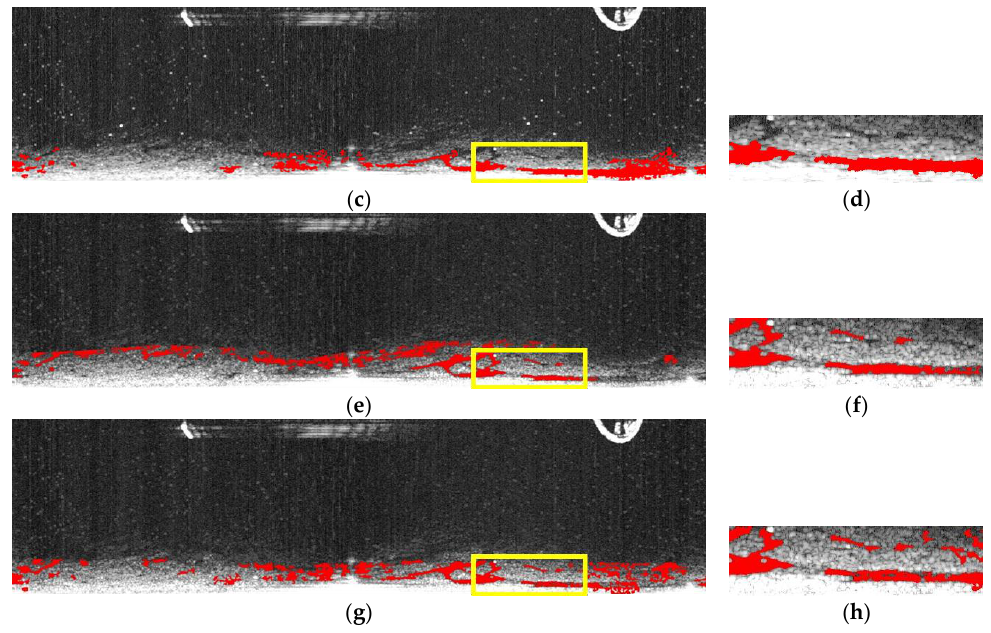
Figure 16. Comparing oil spill detection by three methods: ( a ) original image; ( b ) enlarged version of the highlighted area in ( a ); ( c ) oil spills detected using the method proposed by Zhu et al.; ( d ) enlarged version of the highlighted area in ( c ); ( e ) oil spills detected using the method proposed by Bradley et al.; ( f ) enlarged version of the highlighted area in ( e ); ( g ) oil spills detected using the improved adaptive enhancement; and ( h ) the enlarged version of the highlighted area in ( g ).